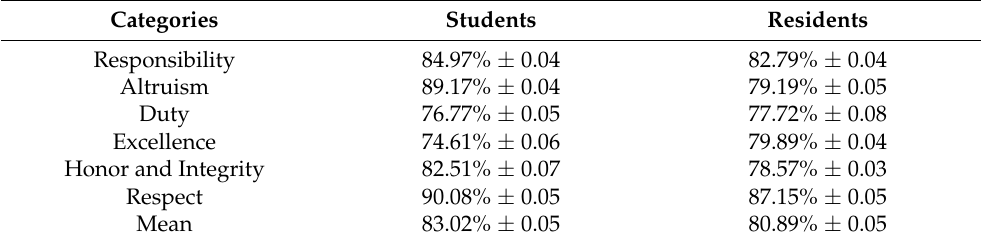
Figure 8. Order of importance of categories for male residents (R, resident). Table 1. Average percentage of positive answers in residents compared with those obtained in a previous study in medical students [9].